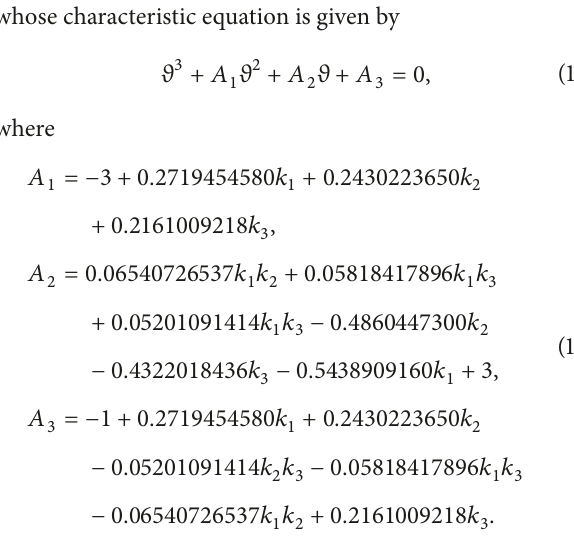
𝑘 = 10 , 𝑘 = 5 , 𝑐 = 0.19 , 𝑐 = 0.18 , and 1 3 1 2